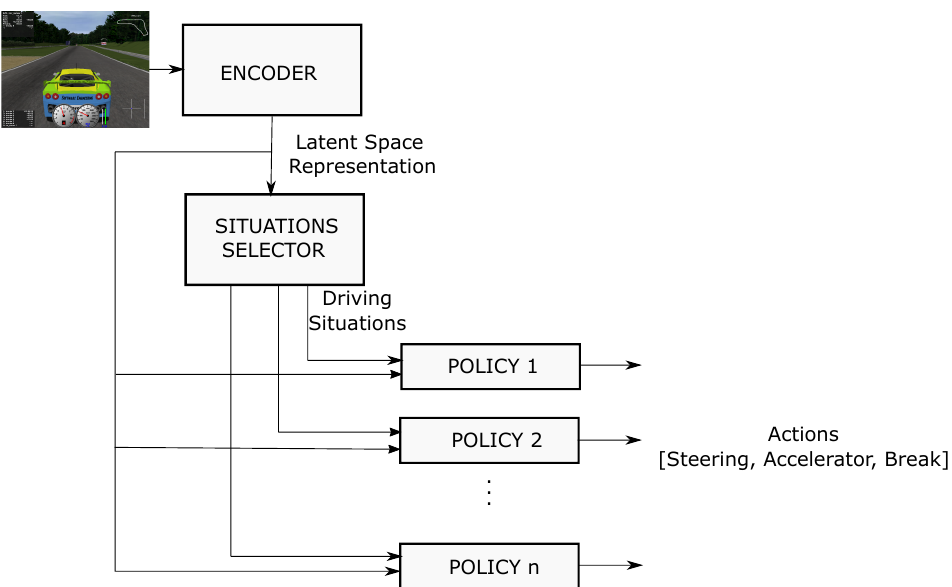
Figure 1. General overview of a behavior selector system that uses the created policies. First, an input image is converted into its latent space representation, and after that, a situation selector classifies these data into driving situations in which each one of them corresponds to a unique driving policy. Every driving policy outputs the necessary actions which correspond to the steering, accelerator, and brake